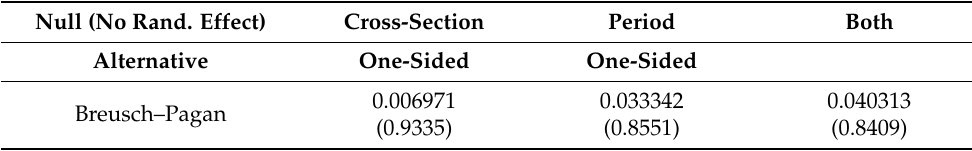
Table 9. Lagrange Multiplier (LM) for Panel